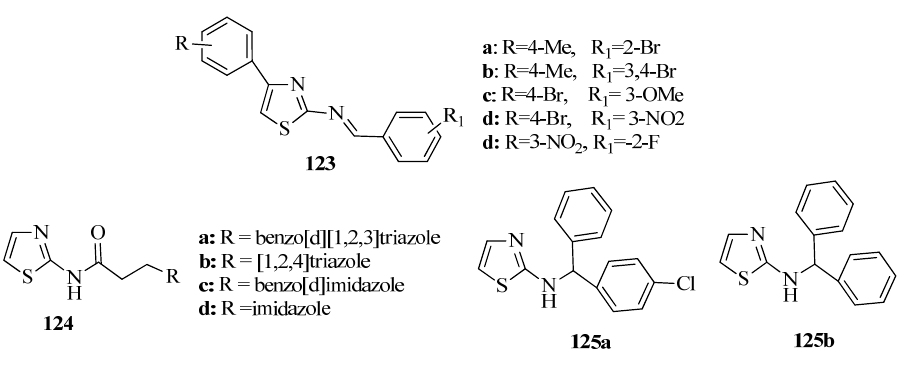
Figure 52. Structures of aminothiazole derivatives.